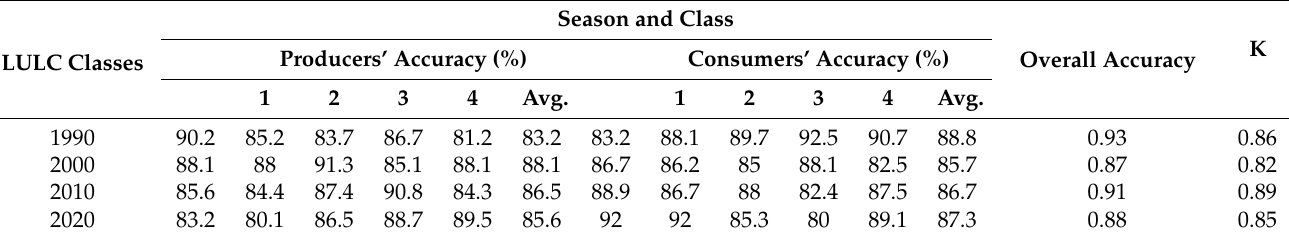
Table 6. Kappa (K) and accuracy of producers and